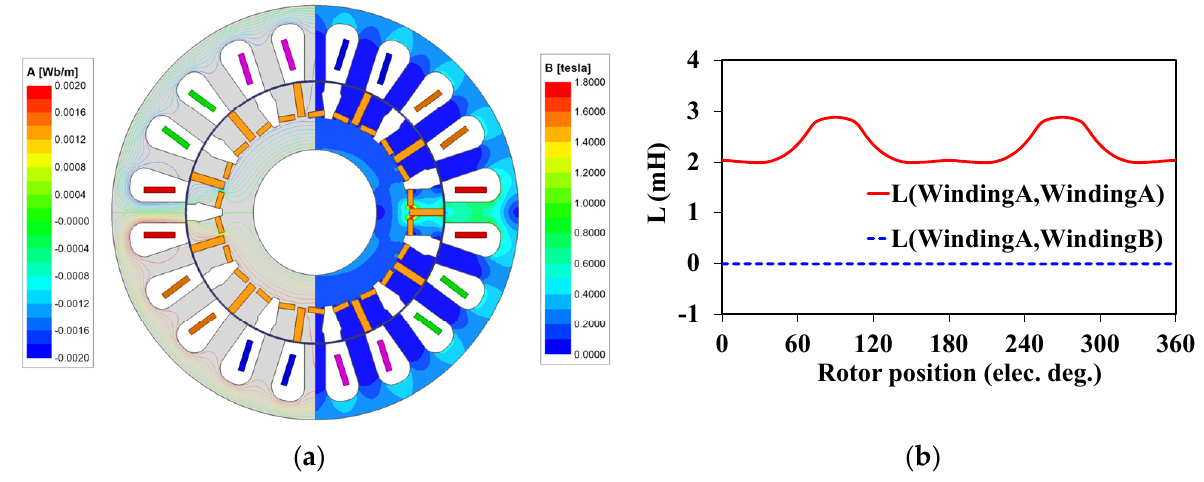
Figure 3. Phase coupling of the fault-tolerant PM motor. ( a ) Single-phase excitation magnetic field